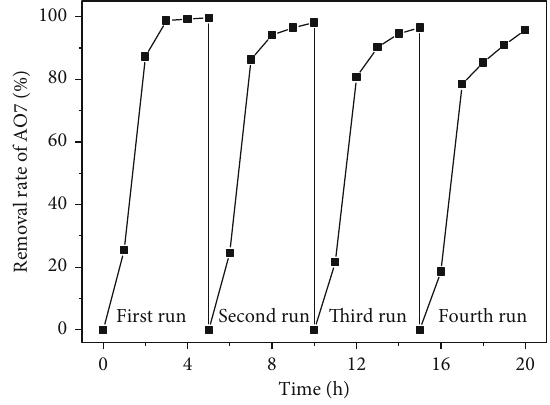
Figure 9: Cycling runs of photocatalytic degradation of AO7 dye with MEA-CeO particles under a 300 W Xenon 2 Figure 8: AO7 adsorption in the dark and AO7 degradation upon illumination with a 300 W Xenon lamp in the presence of Blank-, MEA-, DEA-, and TEA-CeO powders synthesized by 2 solvothermal process combined calcination in air (cid:2) = 1 : 0g/L ; ½ AO7 (cid:2) = 20mg/L ; V = 200 mL ; room ( ½ CeO 2 temperature; without pH preadjustment).